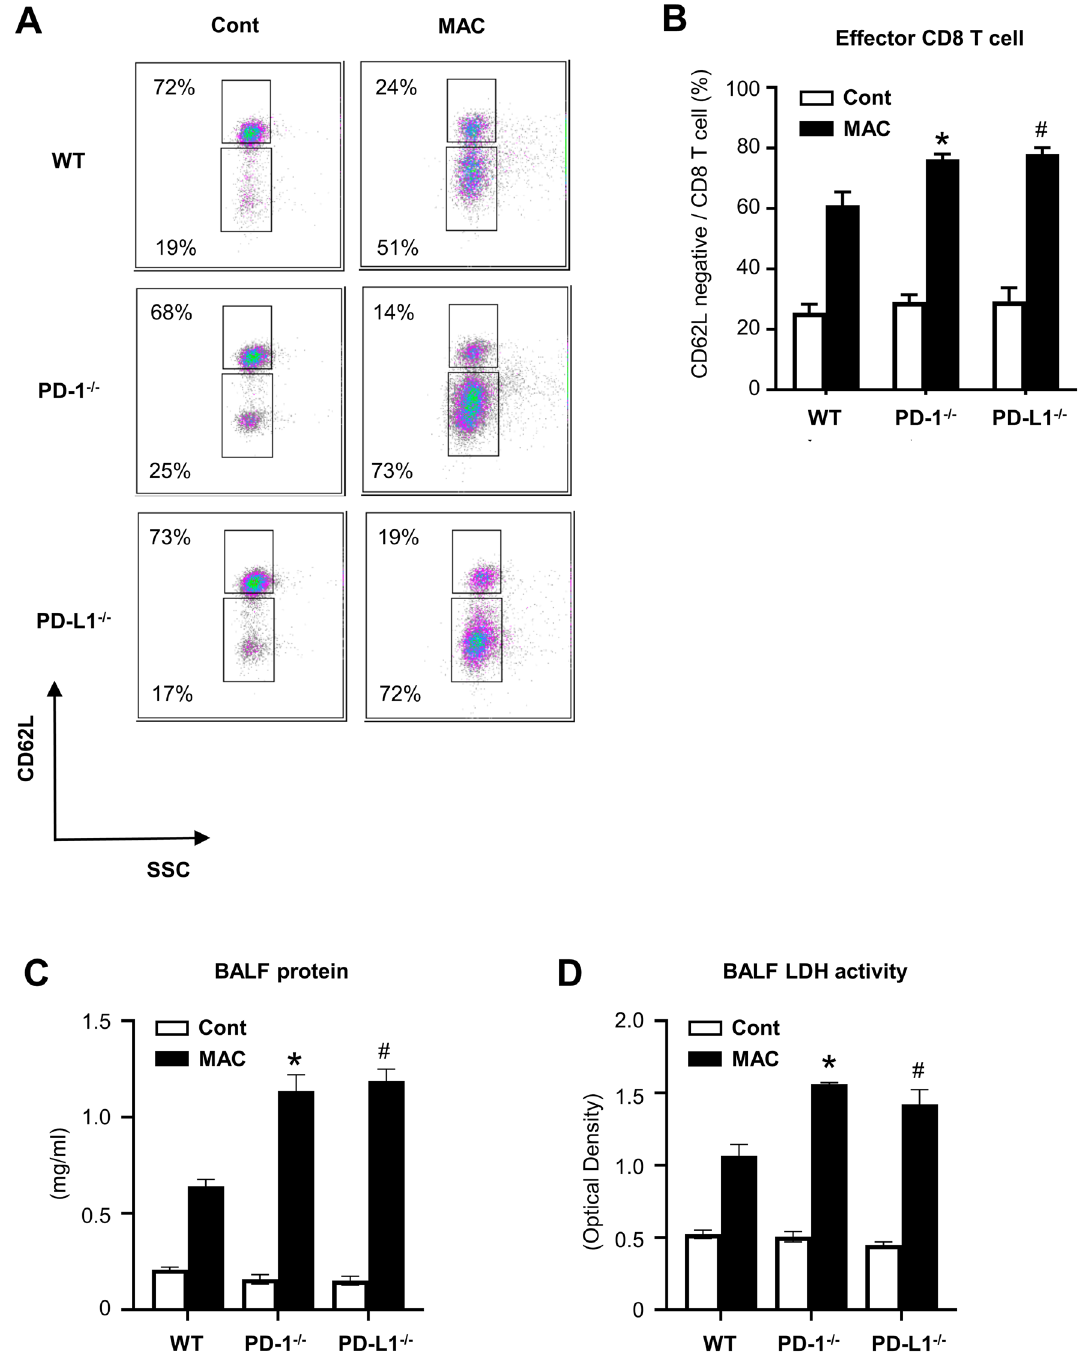
Figure 4. Analysis of CD8-positive T cells in the lungs after MAC infection. ( A ) The proportions of CD62L- negative cells in CD8-positive cells obtained from lungs of wild-type, PD-1 −/− , and PD-L1 −/− mice 60 days after intranasal inoculation of 1 × 10 7 CFU of MAC or saline (Cont). Representative plots are shown. CD8-positive T cells were analyzed for their cell surface expression of CD62L. ( B ) The mean proportions of four samples are shown. ( C ) The concentrations of total protein in BAL fluids of wild-type, PD-1 −/− , and PD-L1 −/− mice 60 days after intranasal inoculation of 1 × 10 7 CFU of MAC. ( D ) LDH cytotoxicity in BAL fluids of wild-type, PD-1 −/− , and PD-L1 −/− mice 60 days after intranasal inoculation of 1 × 10 7 CFU of MAC. The experiments were performed in duplicate with four mice in each group. Data are expressed as means ± SEM. Significance was defined as a P value of < 0.05. *Significant difference between wild-type mice and PD-1 −/− mice (P < 0.05). # Significant difference between wild-type mice and PD-L1 −/− mice (P <